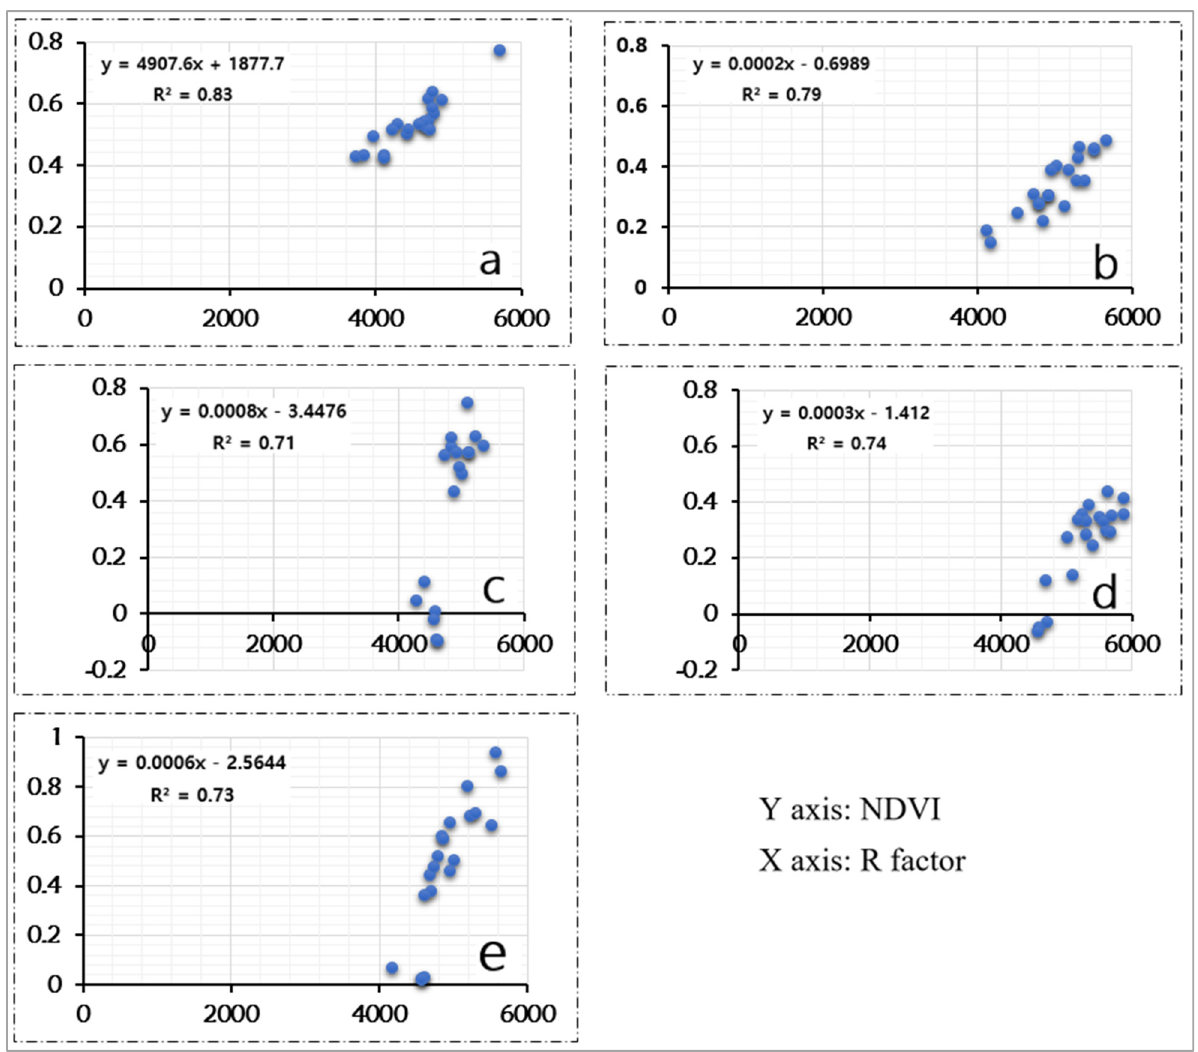
Figure 7. Correlation coefficients between NDVI and rainfall for the considered years: ( a ) 2000, ( b ) 2005, ( c ) 2010 ( d ) 2015 and ( e ) 2018.